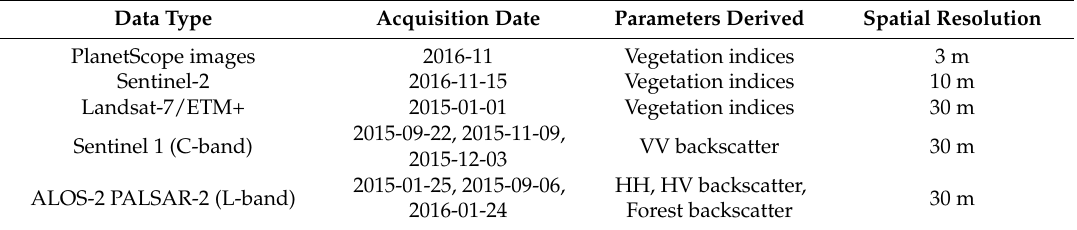
Table 2. Data sources and acquisition dates for estimating forest structure using satellite remote